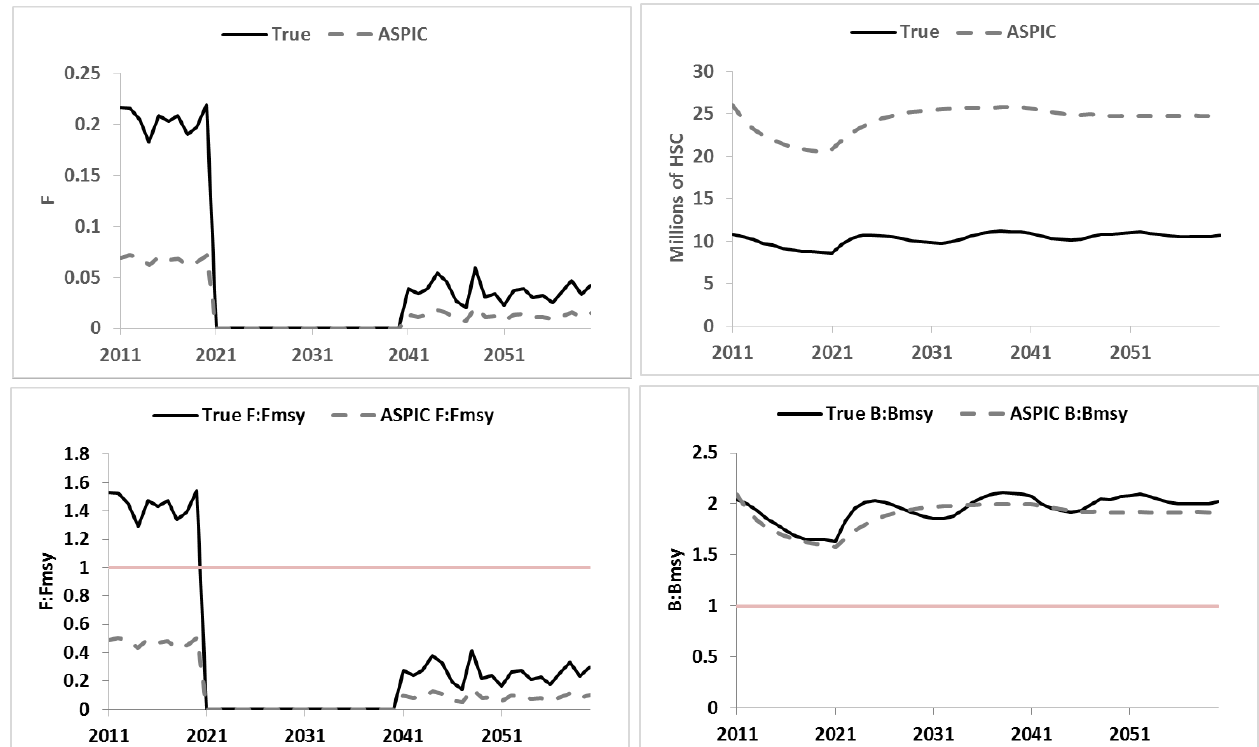
Figure 93. Comparison between simulated “true” data from the operating model and surplus production (ASPIC) results for simulation